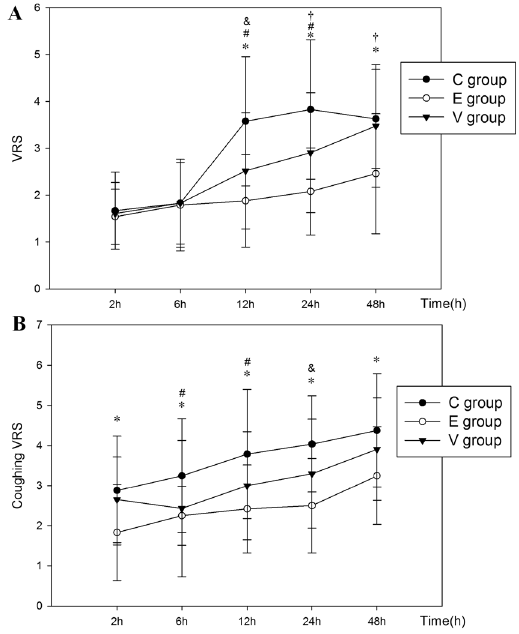
Figure 4. Changes in resting VRS (a) and coughing VRS (B) (mean and SD) in Group C, Group E and Group V. Measurements were recorded at 2, 6, 12, 24 and 48 h after surgery. Group E vs. Group C, * p < 0.01; Group C vs. Group V, # p < 0.05; Group E vs. Group V. & p < 0.05 and † p < 0.01.